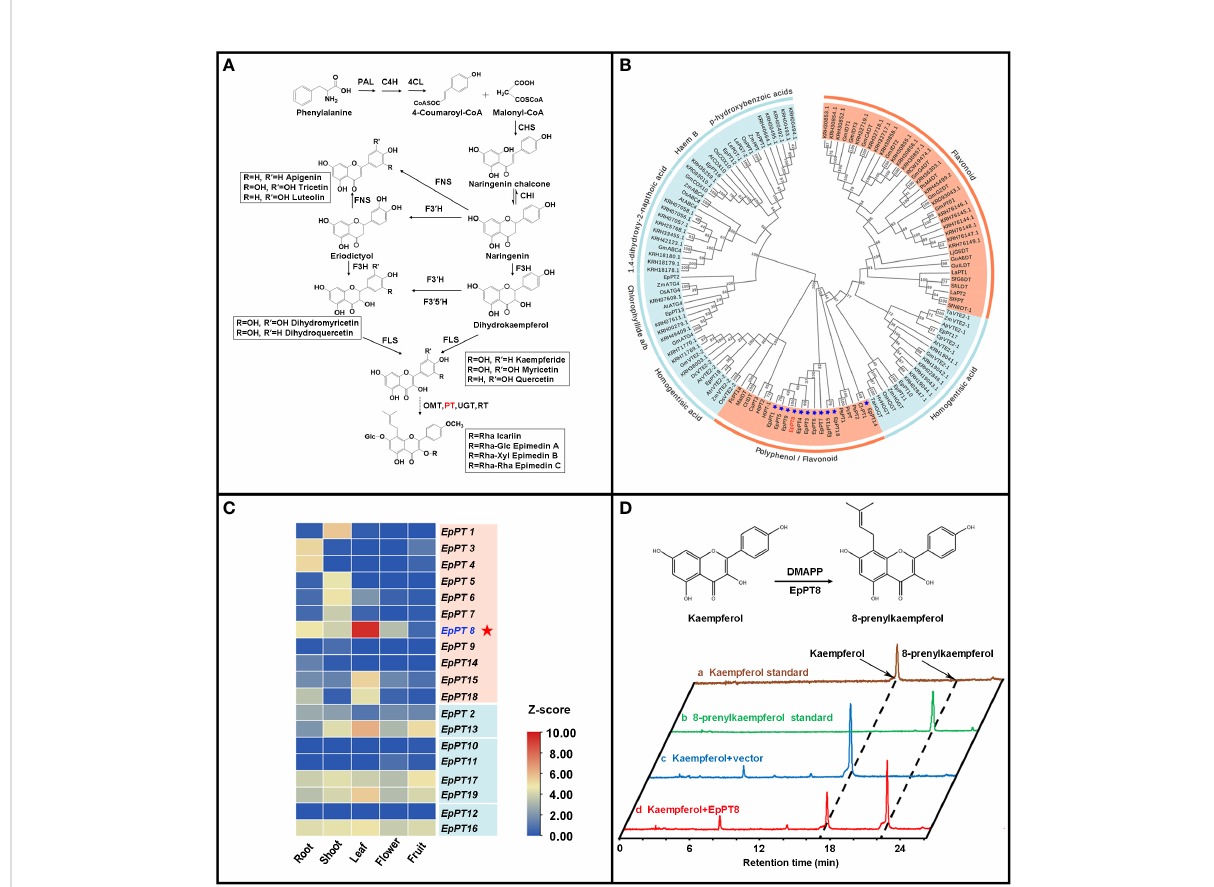
FIGURE 4 Analysis of speci fi c prenyltransferase genes for biosynthesis of prenylated fl avonoids. (A) Biosynthetic pathways of prenylated fl avonoids in E . pubescens . (B) Phylogenetic tree of prenyltransferase genes (PTs). Clades of PTs were classi fi ed by their respective substrates, including two categories, fl avonoid/ polyphenol and others labeled with coral color and light blue color respectively; 11 candidate fl avonoid PTs from E pubescens were marked with blue star and EpPT8 was highlighted with red color. (C) Expression pro fi les of 19 putative E . pubescens prenyltransferase genes (EpPTs) in different tissues. Expression levels in the heatmap were scaled from blue to red (low to high); protein IDs were labeled on the right of heatmap; different tissue samples were labeled at the bottom. (D) Veri fi cation of the products from the reaction catalyzed by recombinant EpPT8 protein using kaempferol as substrate. The reaction catalyzed by EpPT8 was illustrated on the top part of the panel; at the bottom part of the panel, HPLC chromatographs at 254 nm from the examined standards and different reaction mixes were colored with gold, green, blue and red color, representing Kaempferol standard, 8- prenylkaempferol standard, the reaction mix of Kaempferol+vector and the reaction mix of Kaempferol+EpPT8 respectively; the peaks of Kaempferol and 8-prenylkaempferol were pointed out on the fi rst chromatograph with black arrows separately and the corresponding peaks of other three chromatographs were indicated through black dotted